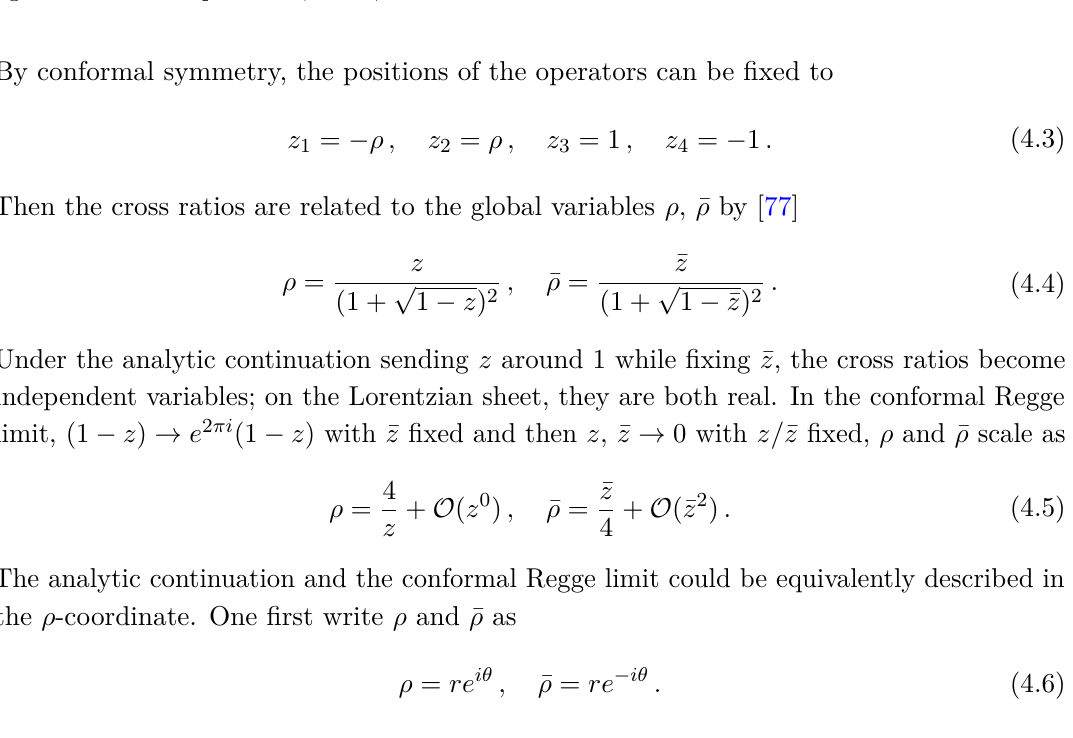
Figure 1 . The conformal Regge limit depicted in the global ρ -coordinate. The dotted lines are the light-cones of the operators φ and φ †